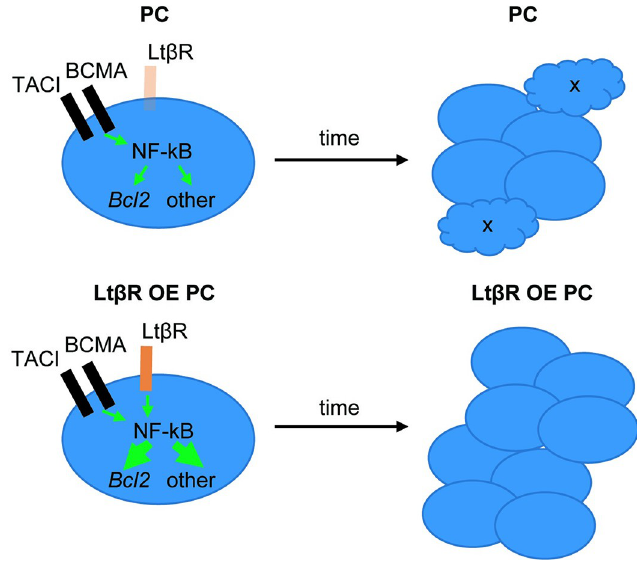
Fig 7. Model for LT β R over-expression (OE) effect on PC accumulation. In WT PCs, TACI and BCMA are highly expressed while LT β R expression is very low. Under conditions where LT β R is OE, there is an overall increase in signaling via NF-kB leading to augmented Bcl2-family protein expression and reduced apoptosis, and to increases in other NF-kB target genes that augment PC accumulation. While TACI and BCMA signaling is ligand (BAFF, APRIL) dependent, the OE LT β R may signal in a ligand independent manner. Chronic LT β R OE in PCs due to gene amplification may allow marked over accumulation of PCs, increasing the chances of additional genetic variants emerging and progression to